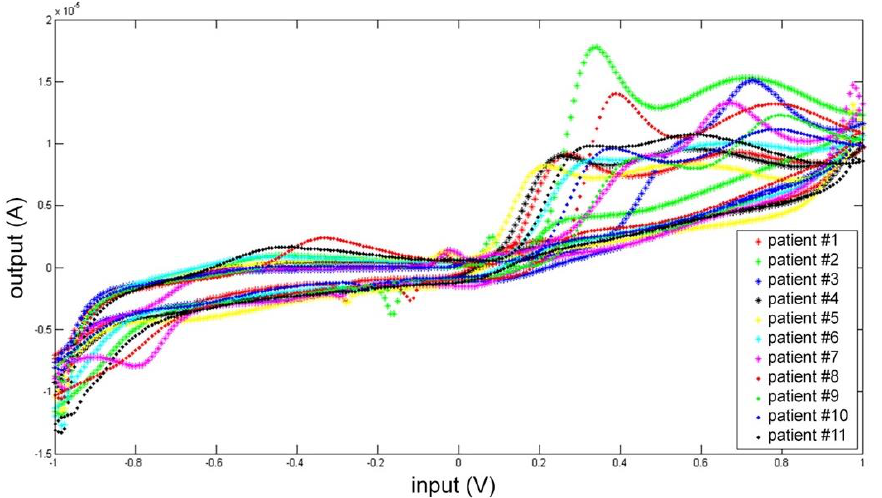
Figure 7. Cyclic voltammetry fingerprint of human CSF samples of the 11 patients enrolled over- lapped in the same graph.